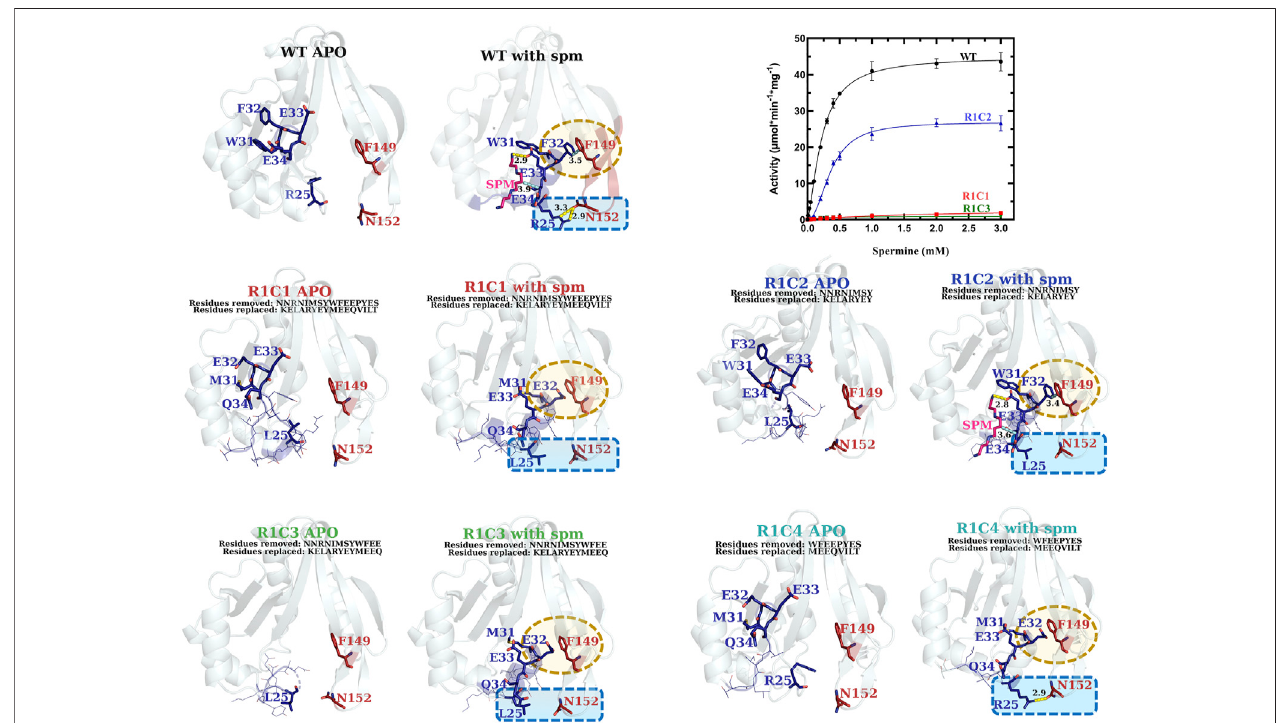
FIGURE 8 | Comparison of kinetic activity and structures/models of Region 1 chimeric constructs (R1C1-R1C4). The apo-crystal structures of R1C2 and R1C3 and homology models of R1C1 and R1C4 are shown adjacent to homology models of R1C1-R1C4 constructs based on the WT spm-bound crystal structure (PDB ID: 4mi4) and are labeled in different colors for clarity. Regions of variability are highlighted in yellow and blue dotted shapes. H-bonds are shown as dashed yellow lines. Speci fi c residues of interest are shown as sticks and labeled and lines of less interest are shown as lines and are not labeled. A plot of the substrate saturation curves for these constructs and WT proteins is also